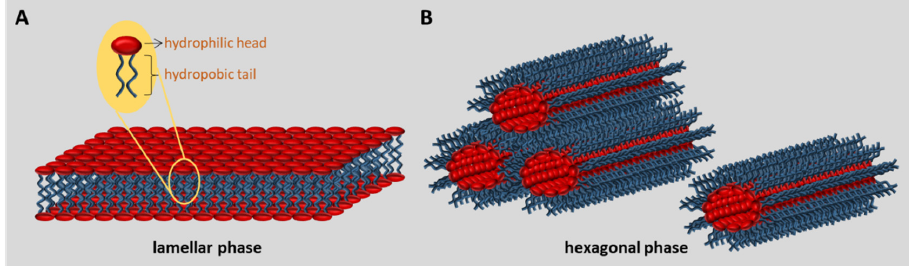
Figure 2. Lipid structure polymorphism. ( A ) Membrane lipids at the lamellar phase composed of a phospholipid bilayer. ( B ) Membrane lipids at the hexagonal phase. Red circles represent the hydrophilic head and the blue line represent the hydrophobic tails.